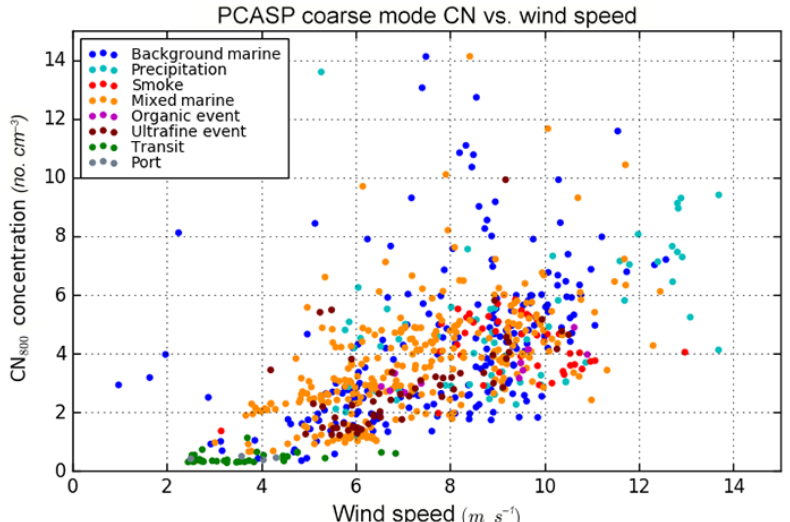
Figure 5. Number concentrations of coarse-mode particles ( D p ≥ 800nm) measured by the PCASP as functions of local surface wind speed measured by the onboard Vasco weather station. Each point was averaged over the same approximately 15min time period as for the CCN system measurements and is colored by the aerosol type as described in the